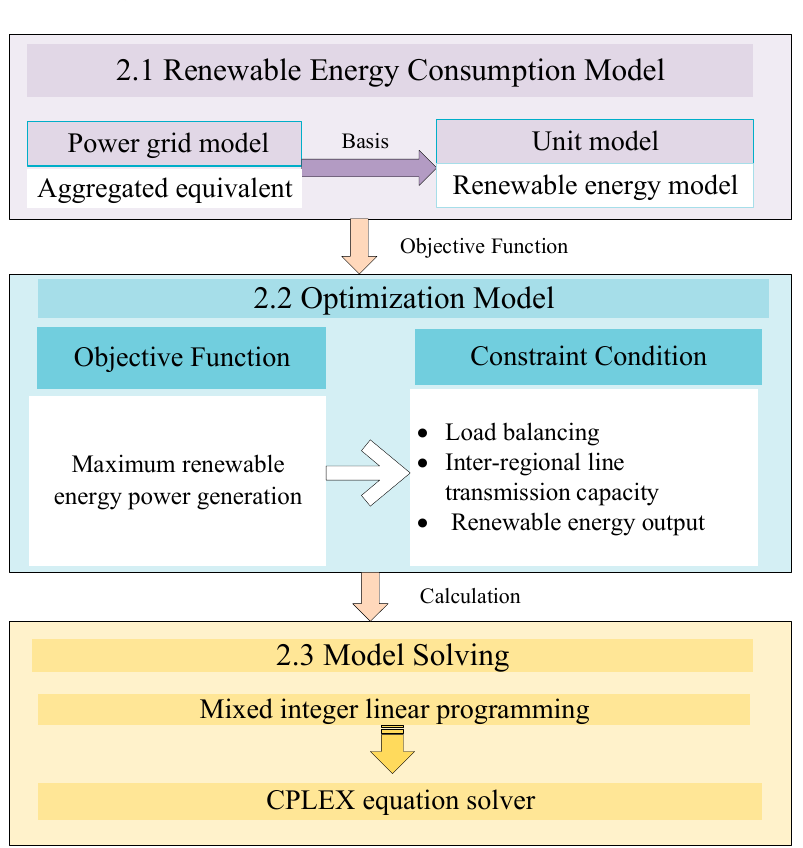
Figure 1. Schematic diagram for time ‐ series production simulation.